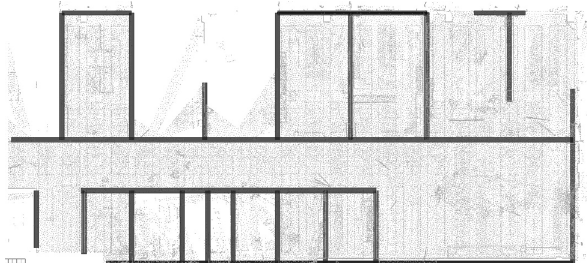
Figure 11 . The lines obtained from the process on an example of a point